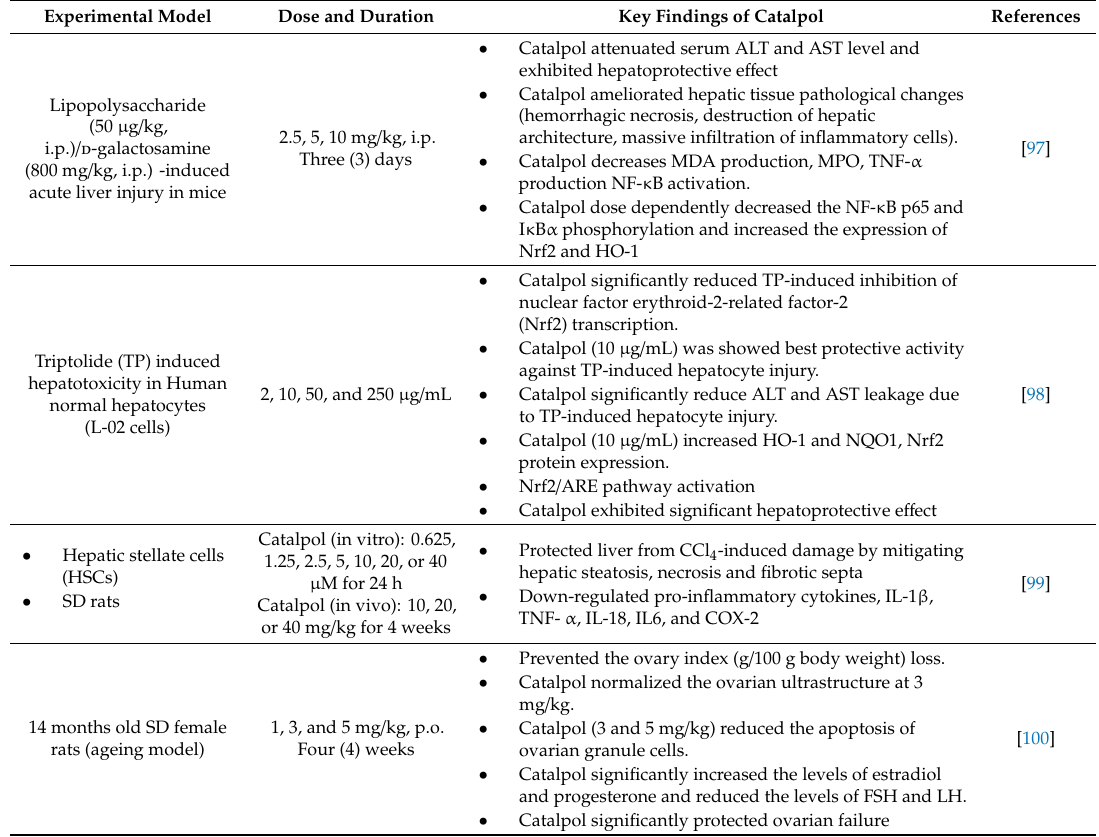
Table 6. Other biological e ff ects of catalpol and their underlying